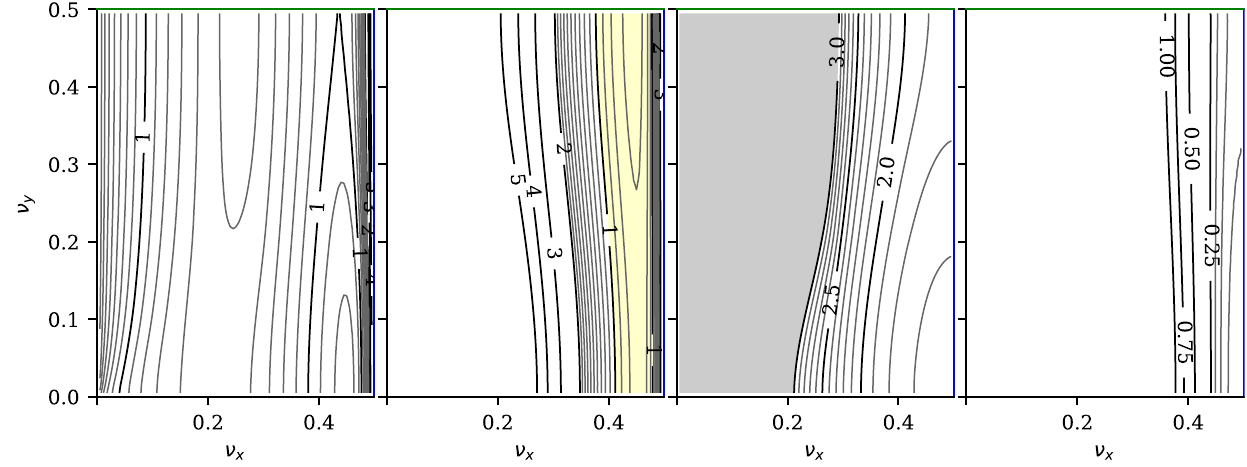
FIG. 8. From left to right: (1) optimal G objective, (2) emittance ratio F for G objective, (3 – 4) quantities like in Fig. 4 (see legend therein) for optimal G .